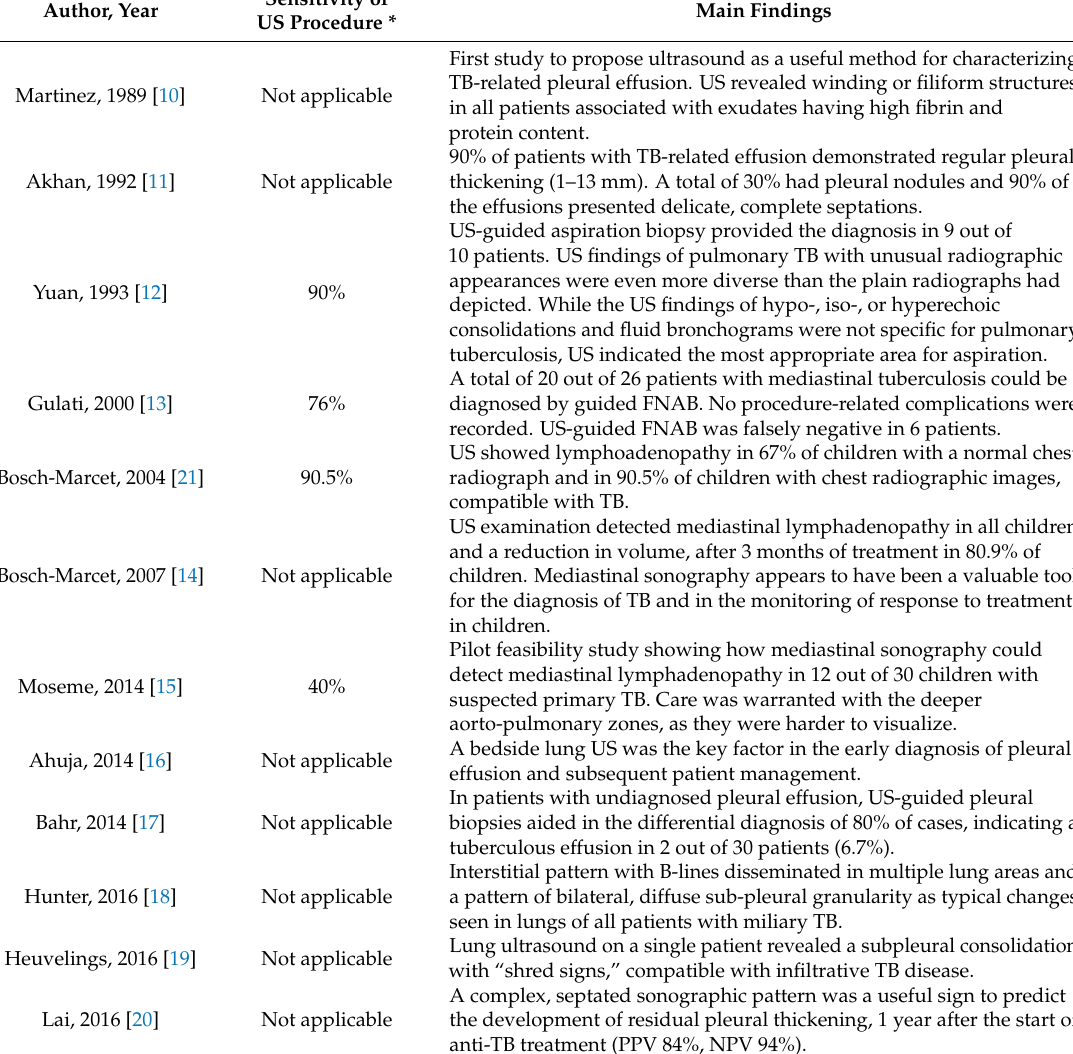
Table 2. Main findings of the studies